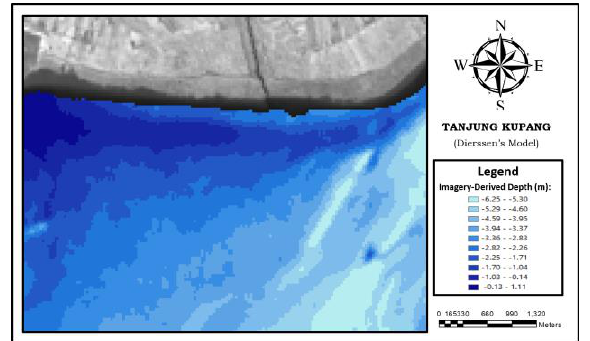
Figure 3. Imagery-derived bathymetric model from Dierssen’s approach over the study area.